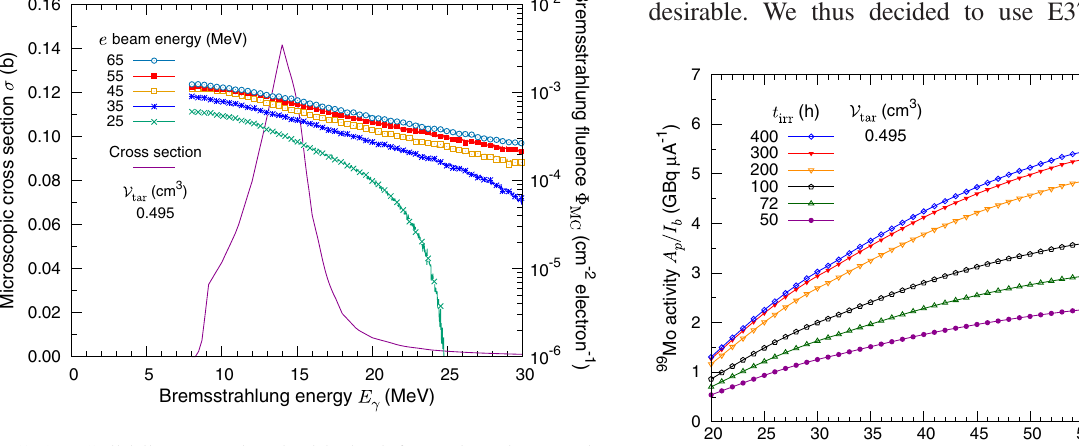
FIG. 3. Solid line, associated with the left y -axis: microscopic cross section of 100 Mo ð γ ; n Þ 99 Mo. Lines with points, associated with the right y -axis: bremsstrahlung fluences simulated at different electron ( e ) beam energies.